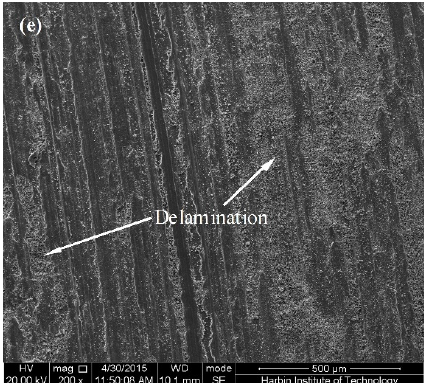
Figure 16. Worn surface morphology of the rheoformed composite parts with different volume fraction of SiC particles: ( a ) 0, ( b ) 0.5%, ( c ) 1.0%, ( d ) 1.5% and ( e ) 2.0%.